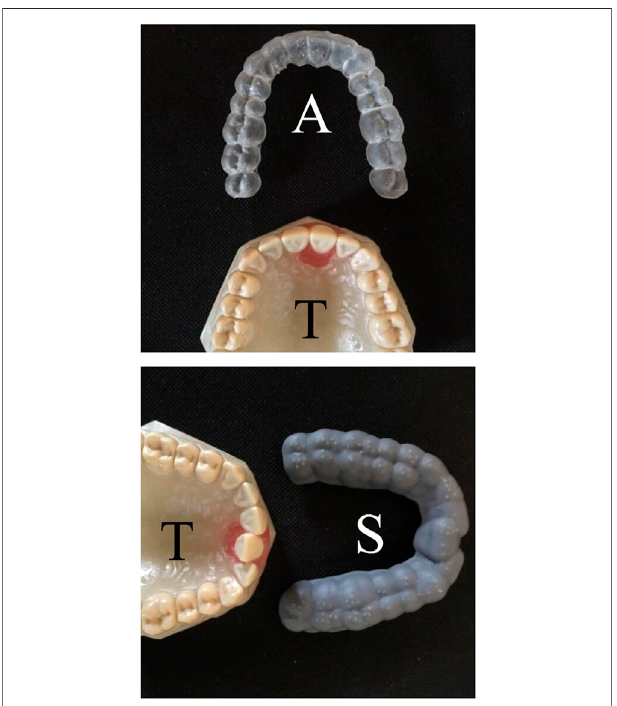
FIGURE1| Acustom-madetypodont (T),a4D-printedaligner(A),anda gray splint (S).